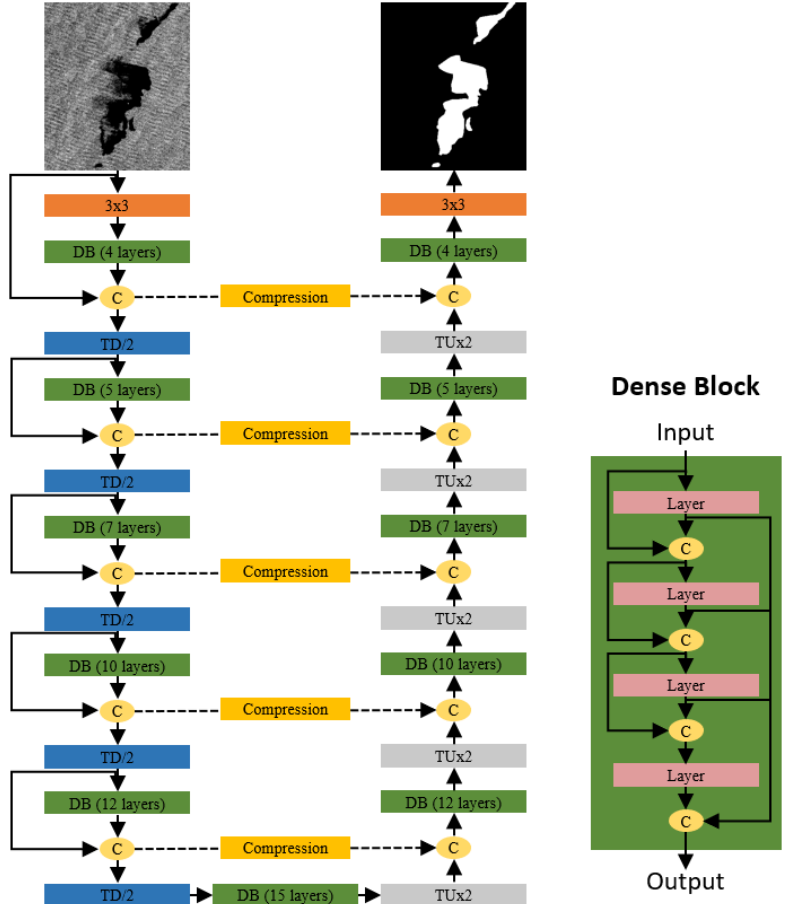
Figure 4. Architecture of the enhanced FC-DenseNet version. Orange blocks are convolutions, DB: dense blocks, TD: transitions down (2 times spatial downscale), TU: transitions up (2 times spatial upscale), C corresponds to the concatenation operation, and the dashed lines are skip